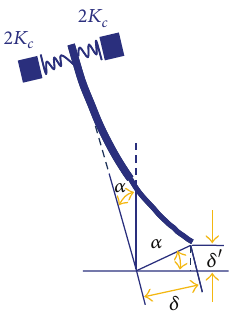
Figure 4: Actual deformation in processing of ball-end